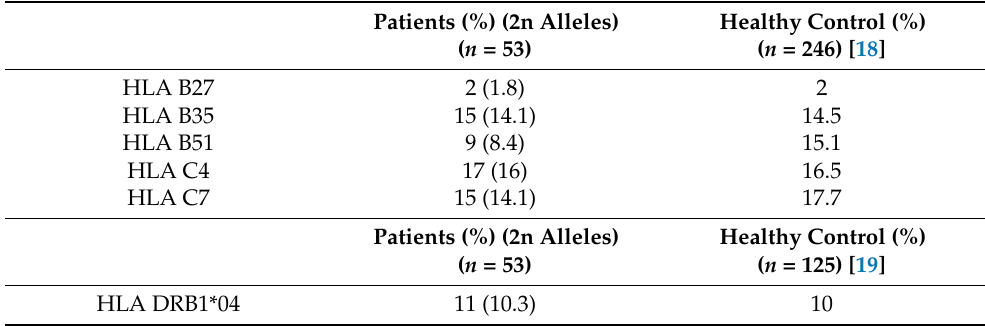
Table 1. Frequency of HLA B27, B35, B51, C4, C7 and DRB1*04 in group of patients and in control groups.